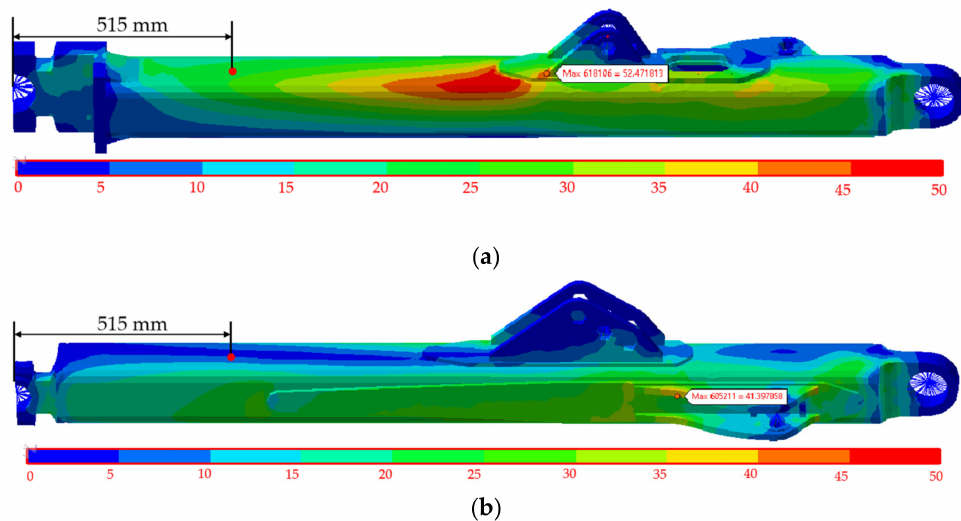
Figure 7. Stress contours: ( a ) left push arm; ( b ) right push arm.